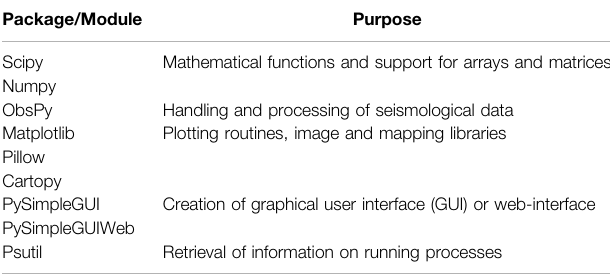
TABLE 1 | List of external python modules and packages required by RETREAT software and their purposes.